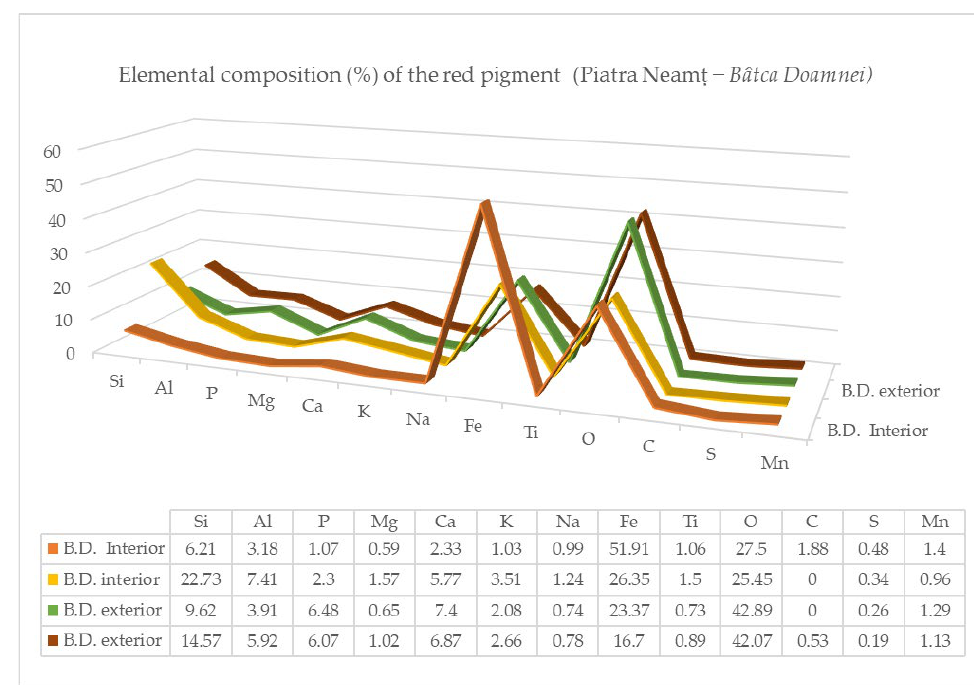
Figure 13. The elemental composition of the red pigment from the Piatra Neamt— Bâtca Doamnei settlement.